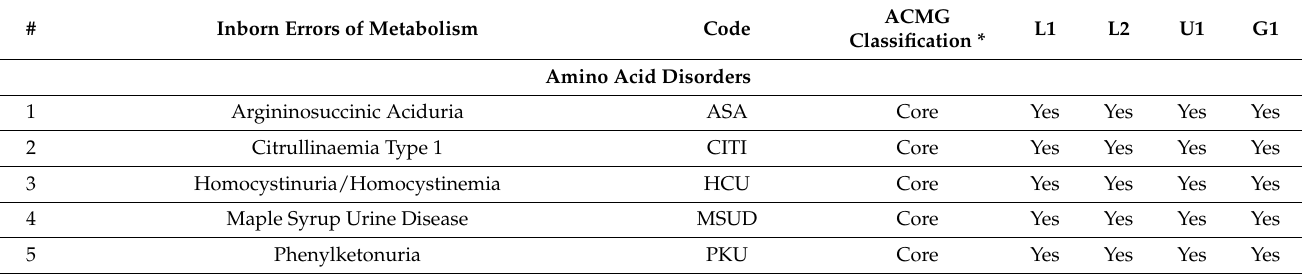
Table A1. A comparison of IMD conditions screened by blood test providers with the American College of Medical Genetics and Genomics (ACMG) Screening